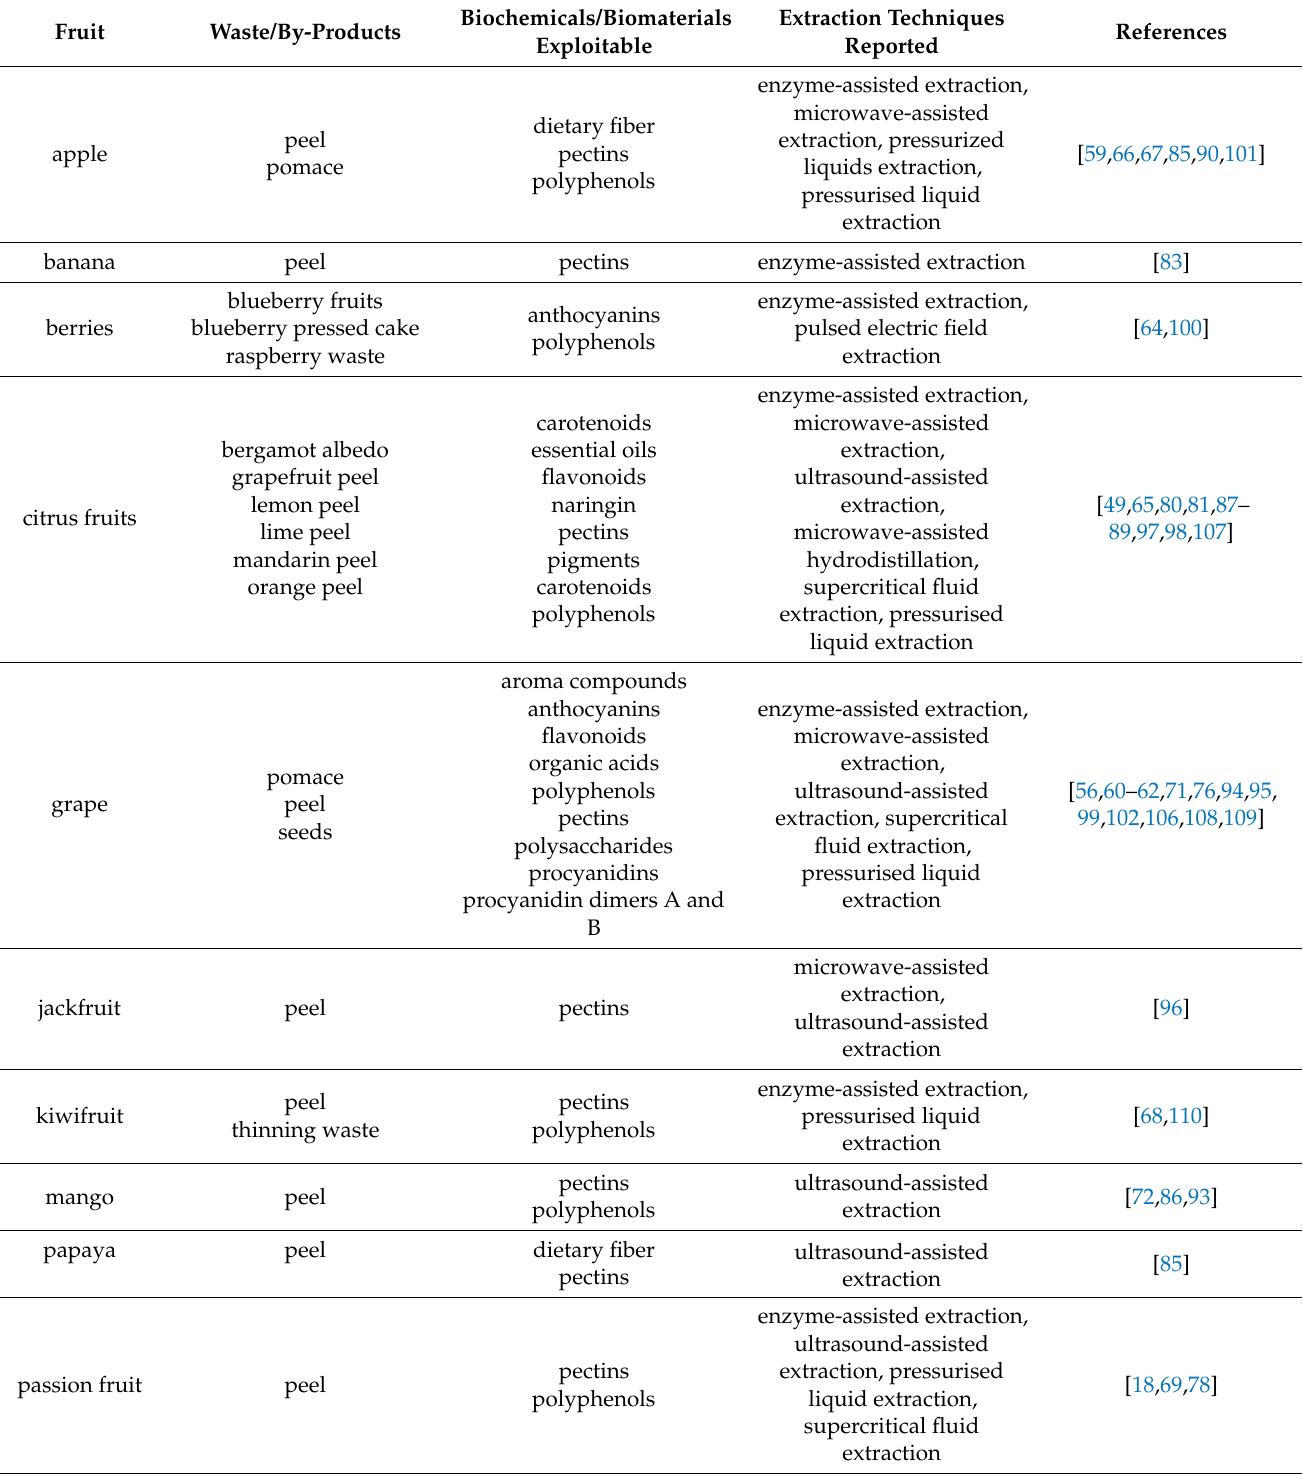
Table 2. Main fruit waste and by-products available in the scientific literature and/or exploited in industrial processes.